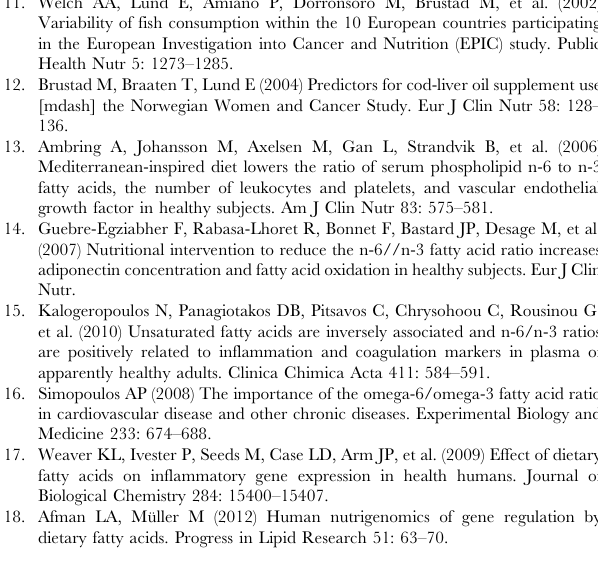
Table S1 Additional characteristics of the study popu- lation (n= 227) and comparison groups (group n =23).